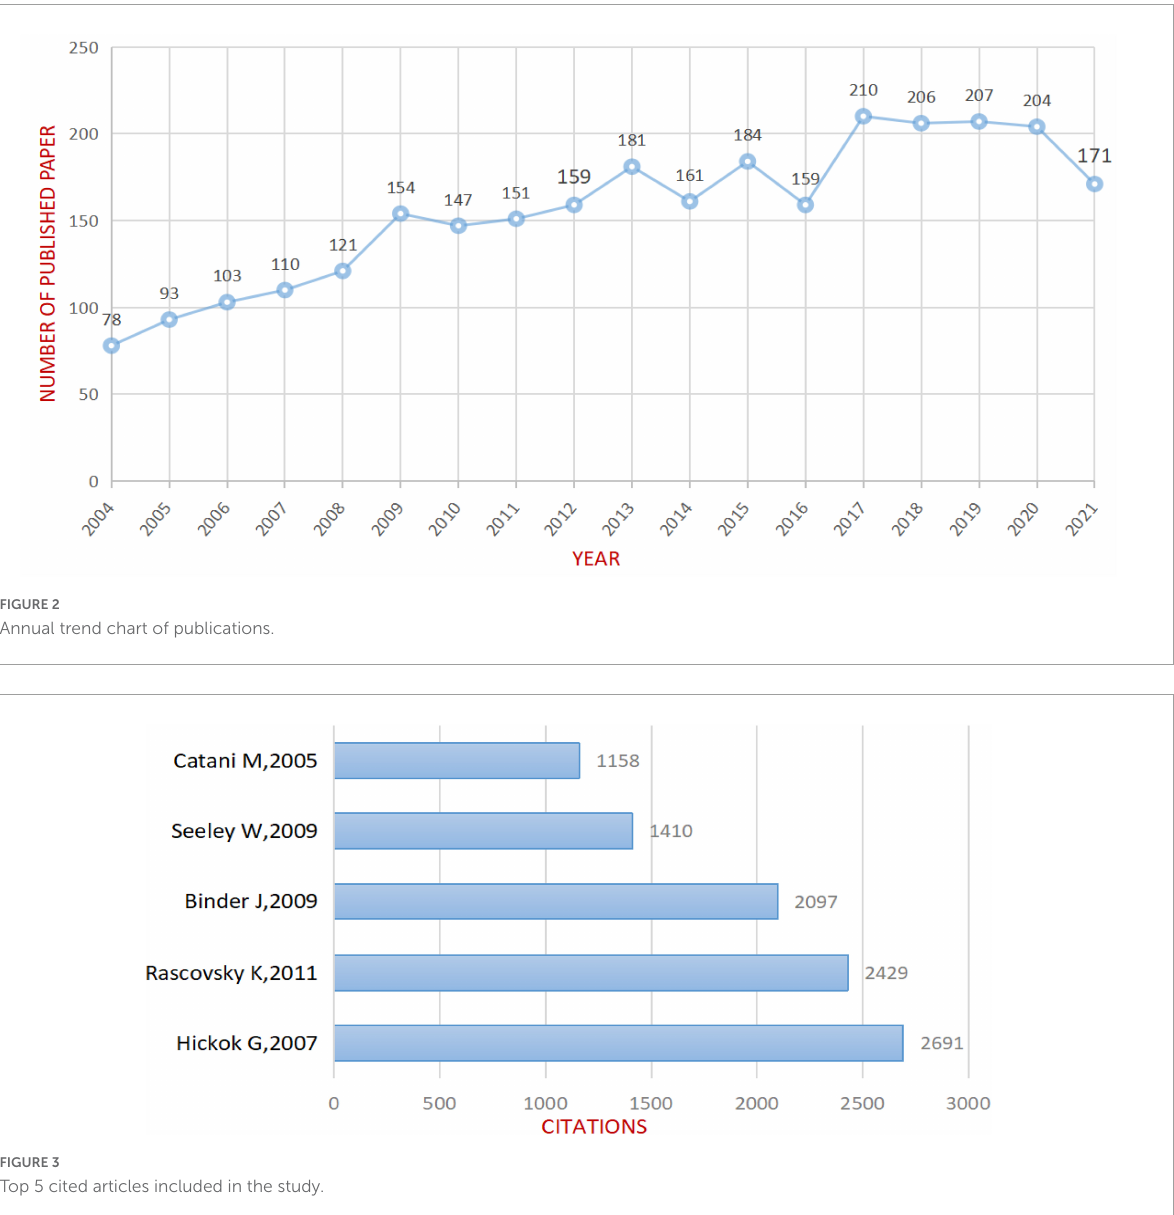
Canada (140, 5.0%), Australia (128, 4.6%), and Spain (102,